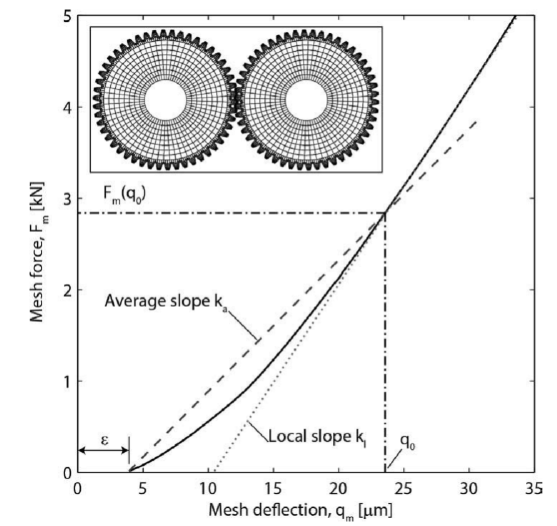
Figure 11. Average and Local slopes for the estimation of the mesh stiffness from